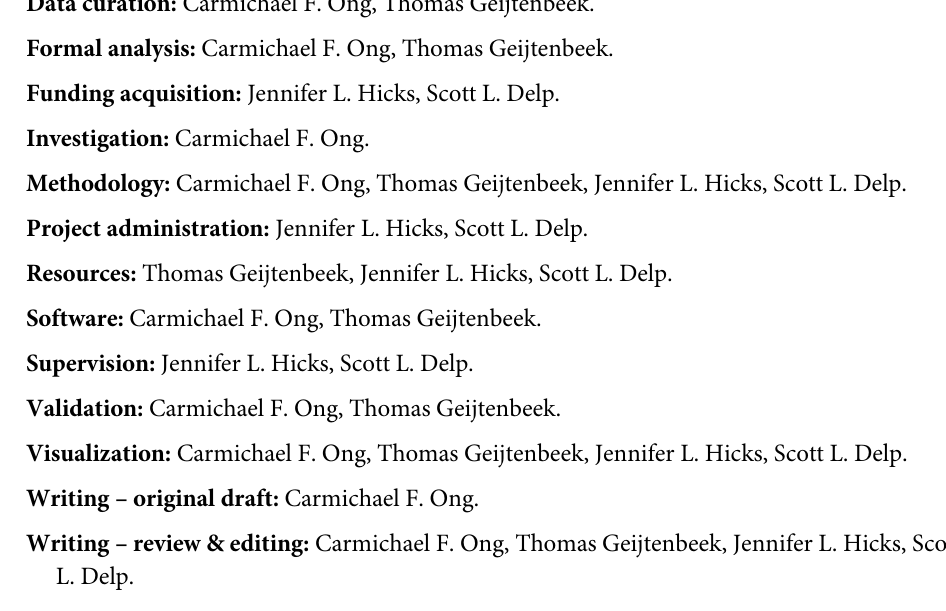
S4 Fig. Kinematic and kinetic trajectories of all simulated deficits. S1 Table. Muscle parameters for the unimpaired musculoskeletal model. (PDF) S2 Table. Initial Covariance Matrix Adaptation Evolutionary Strategy (CMA-ES) standard deviation for each free parameter. S3 Table. Muscle activity comparisons between simulations and Perry and Burnfield , 2010 for Fig